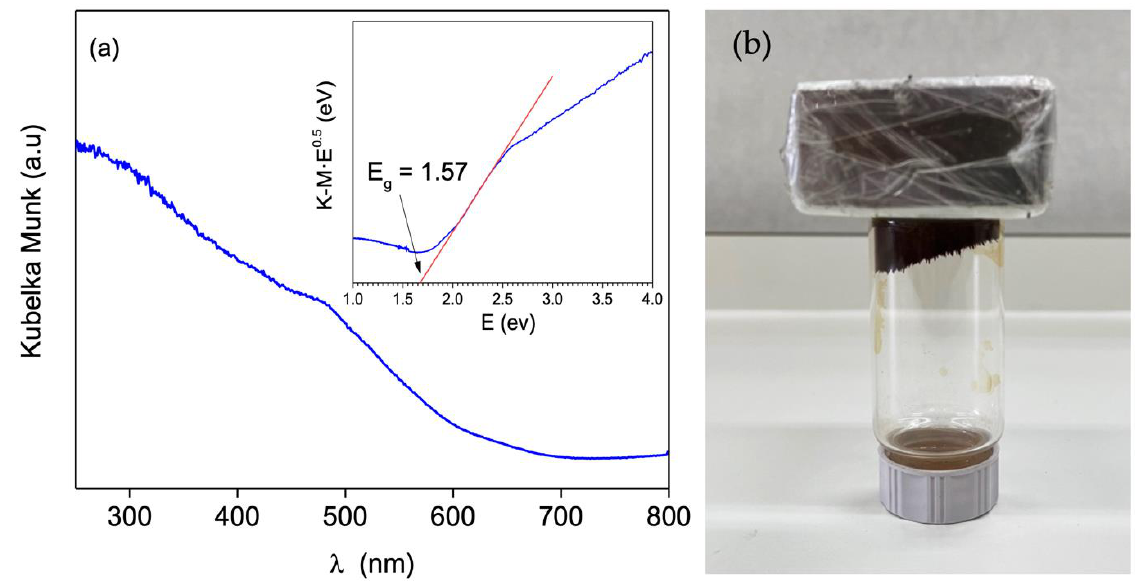
Figure 3. ( a ) UV-Vis spectra and (inset) Tauc’s plots vs. energy (eV) of Fe3O4 sample and ( b ) picture showing magnetic properties.